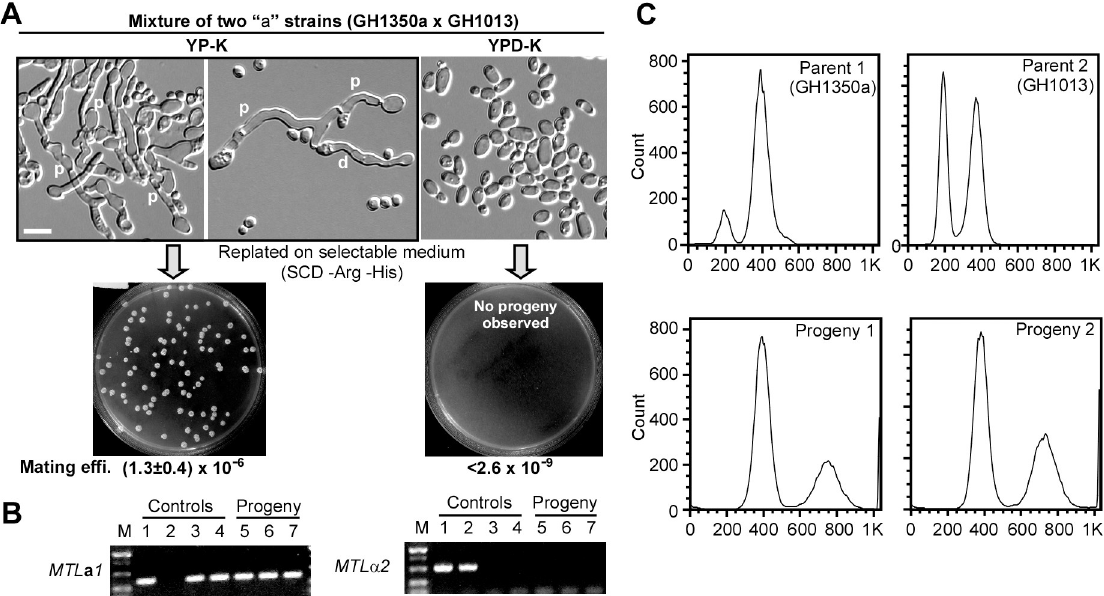
Fig 2. Glucose starvation induces same-sex mating in C . albicans . (A) Same-sex mating between two “ a ” strains (GH1013 and GH1350a). 1 × 10 7 cells of each strain were mixed and cultured on YPD-K and YP-K media at 25˚C. After three days of growth, the mating mixture was replated onto SCD-Arg, SCD-His, and SCD-Arg-His dropout plates to assess mating efficiency. The middle panel (up) indicates that two “ a ” cells underwent cell fusion and a daughter cell grew out from the conjunction tube. Scale bar, 10 μ m. (B) PCR verification of the MTL types. Strains used: lane 1, SN152 ( a / α ); 2, GH1350 ( α / α ); 3, GH1350a ( a / a ); 4, GH1013 ( a / a ); 5–7, progeny strains of the GH1350a × GH1013a cross. (C) FACS analysis of the DNA content of parental and progeny strains. Parental diploids have the standard G1 and G2 cell cycle peaks representing 2C and 4C DNA levels. Mating progeny contain DNA content corresponding to 4C and 8C peaks, confirming their tetraploid nature. Arg, arginine; d, daughter cell; FACS, fluorescence-activated cell sorting; His, histidine; M, DNA ladder; MTL , Mating type locus; p, mating projection; SCD, synthetic complete medium; YPD-K, yeast extract-peptone-glucose- K 2 HPO 4 ; YP-K, yeast extract-peptone-K 2 HPO 4